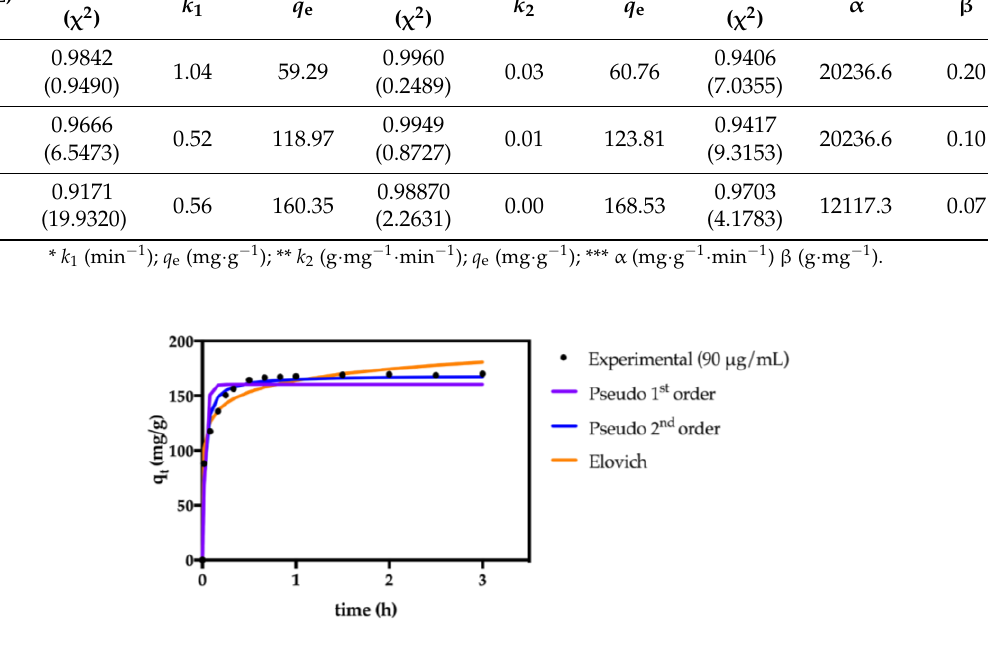
Figure 5. Time profile of adsorption capacity of κ-carrageenan hybrids at variable paraquat initial concentrations (pH 7.3, 25 °C).